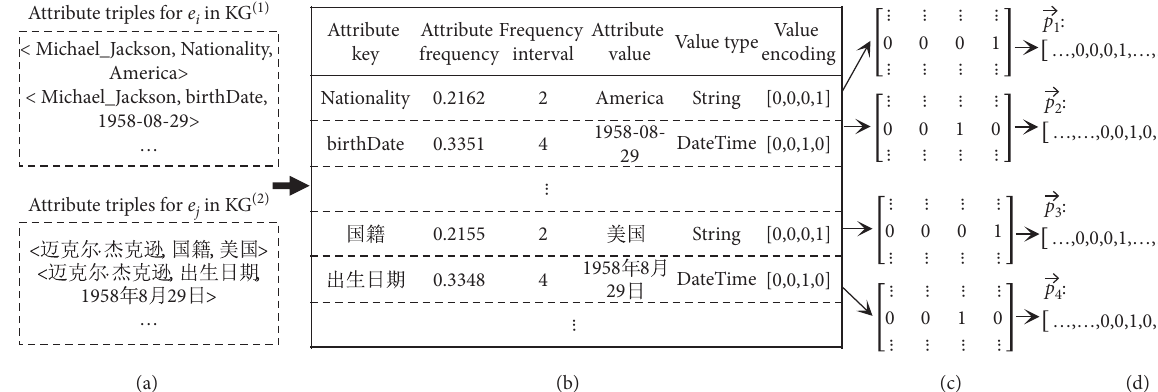
Figure 2: An example of entity attributes representation: (a) attribute triples in each KG are merged into a set of key-value pairs, (b) attribute keys and values are used to represent the frequency feature and type feature, respectively, (c) the frequency and type information are integrated into a sparse matrix, and (d) each attribute pair forms a feature vector.